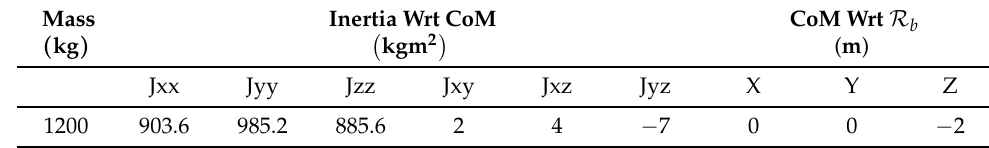
Figure 1. Schematic of the spacecraft model. Table 1. Platform inertial